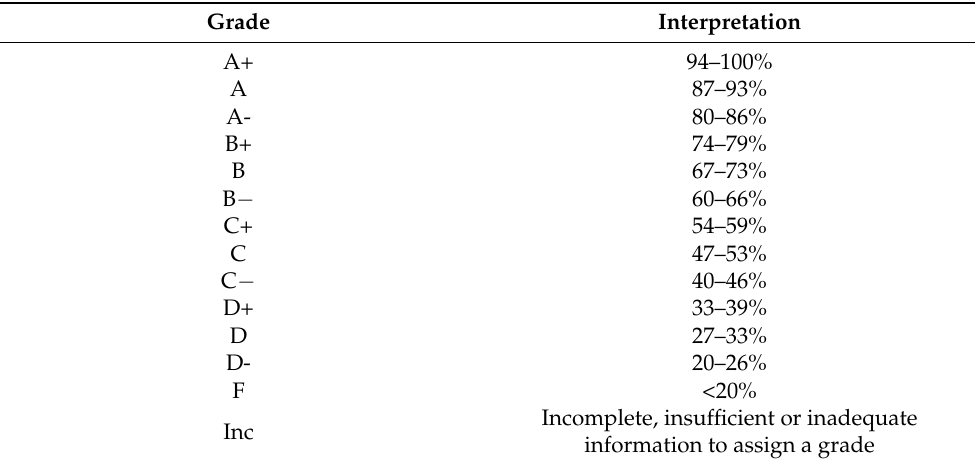
Table 2. The Active Healthy Kids Global Alliance grading rubric.